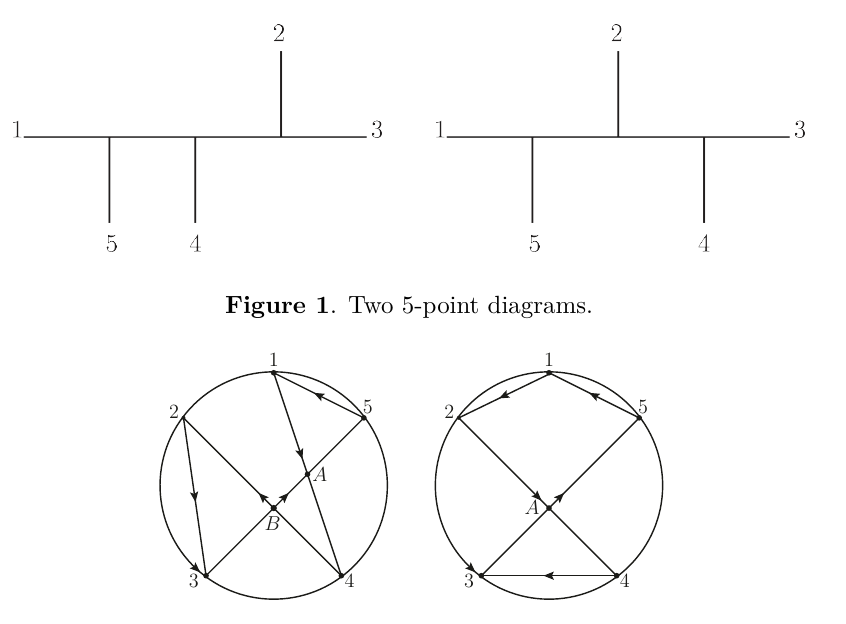
Figure 2 . Diagram for A S (1 , 2 , 3 , 4 , 5 | 1 , 4 , 2 , 3 , 5) and A S (1 , 2 , 3 , 4 , 5 | 1 , 2 , 4 , 3 , 5)